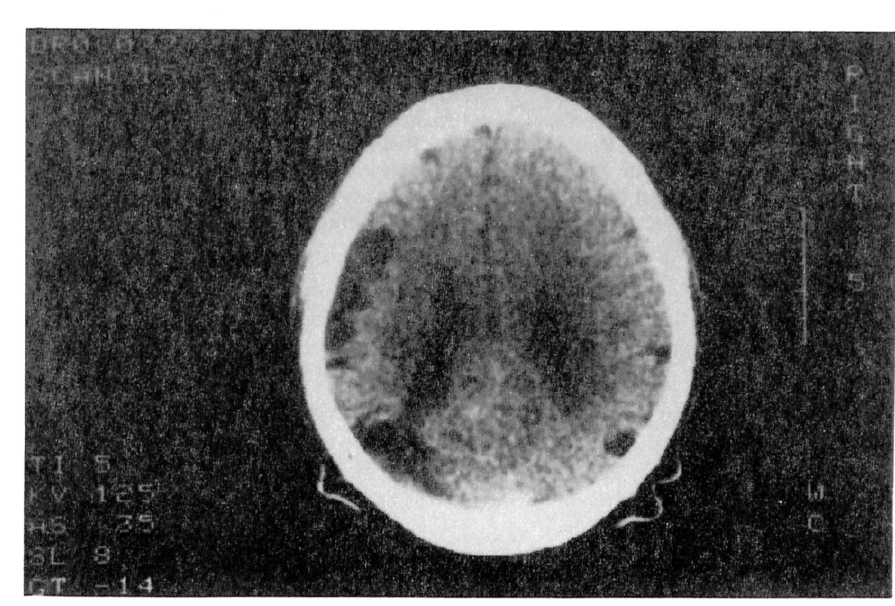
FIG.!. C.T. scan showing loss of cortex in the left temporal/parietal